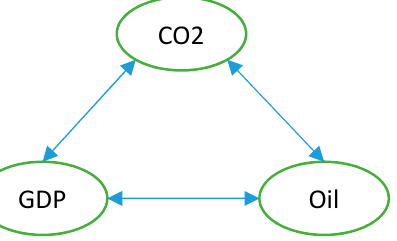
Figure 2. Summary of long ‐ run Granger and homogeneous causality test.